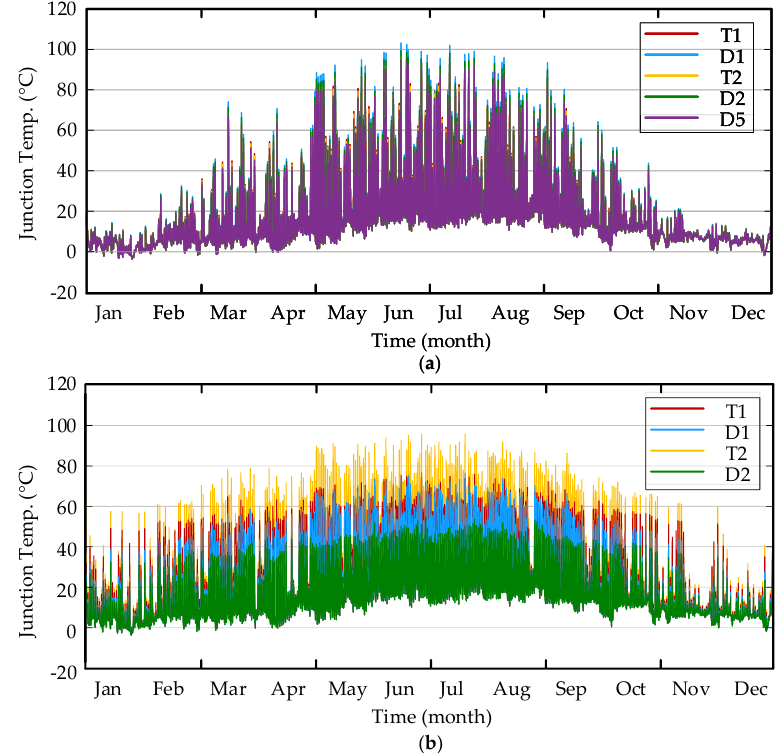
Figure 9. Junction temperature of the power devices within the battery converters (referring to Figure 7): ( a ) in the battery inverter and ( b ) in the battery